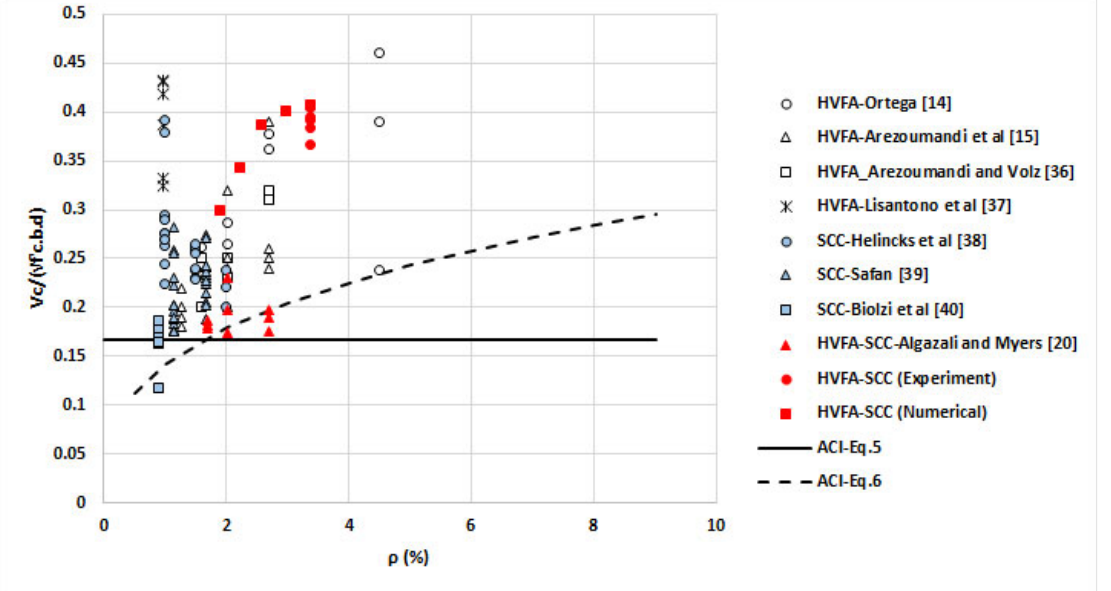
Figure 20. Normalized shear strength of non ‐ conventional concrete vs. longitudinal reinforcement ratio.